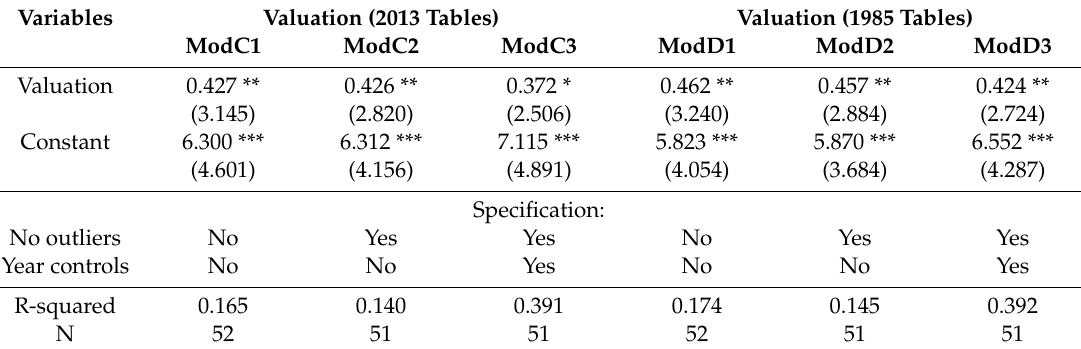
Table 4. Valuation accuracy test 2 (dependent variable is the natural logarithm of the sale price in PLN /